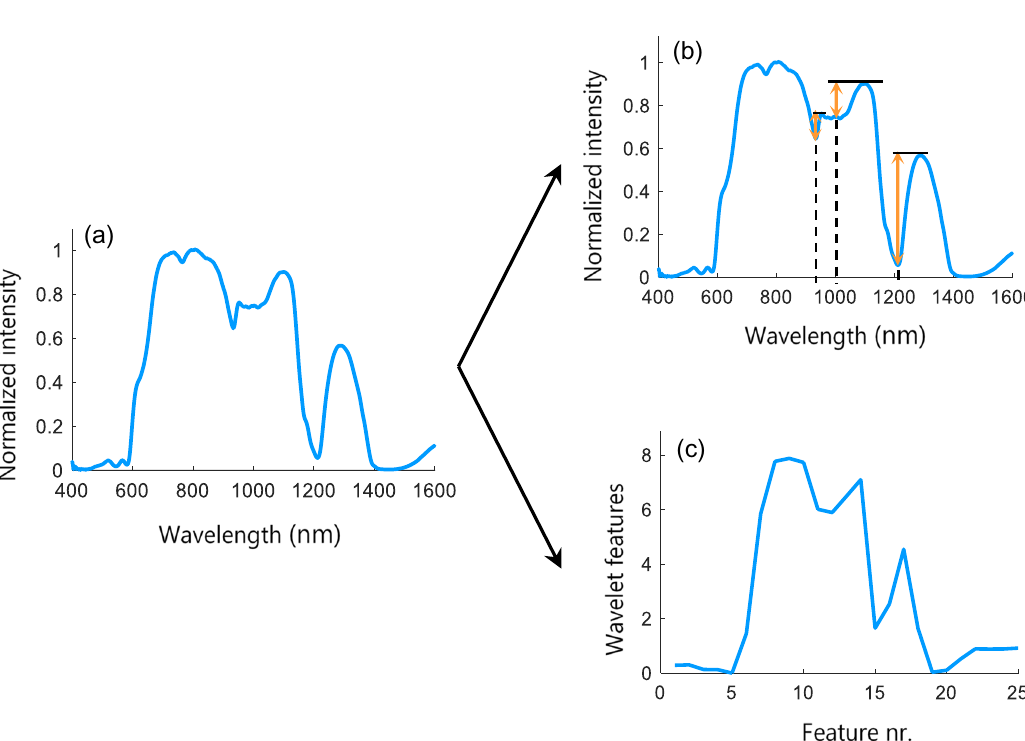
Figure 3. DRS feature extraction methods. ( a ) Original DRS spectrum, consisting of 1200 wavelength features; ( b ) the dip-peak heights for three spectral regions: 935 nm, 985 nm and 1200 nm, resulting in 3 features; ( c ) level 6 approximation spectrum, resulting in 25